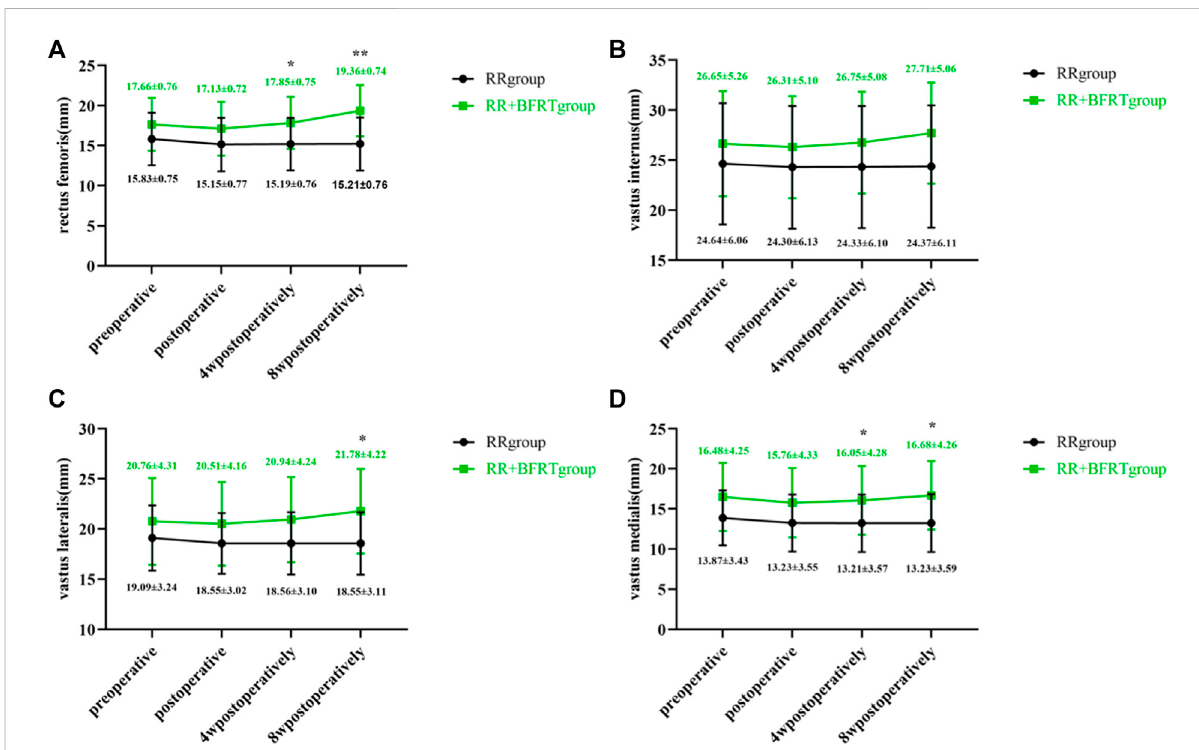
FIGURE 7 Comparison of quadriceps thickness between RR group and RR + BFRT group at different time points (mm). “ * ” indicates a signi fi cant change ( p < 0.05). “ ** ” indicatesasigni fi cantchange( p < 0.01).Valuesarepresentedasmean±SD.RRGroup:routinerehabilitationgroup;RR+BFRTGroup: routine rehabilitation + blood fl ow restriction training group. [ (A) : Comparison of rectus femoris between RR group and RR + BFRT group; (B) Comparison of vastus internus between RR group and RR + BFRT group; (C) Comparison of vastus lateralis between RR group and RR + BFRT group; (D) Comparison of vastus medialis between RR group and RR + BFRT group].